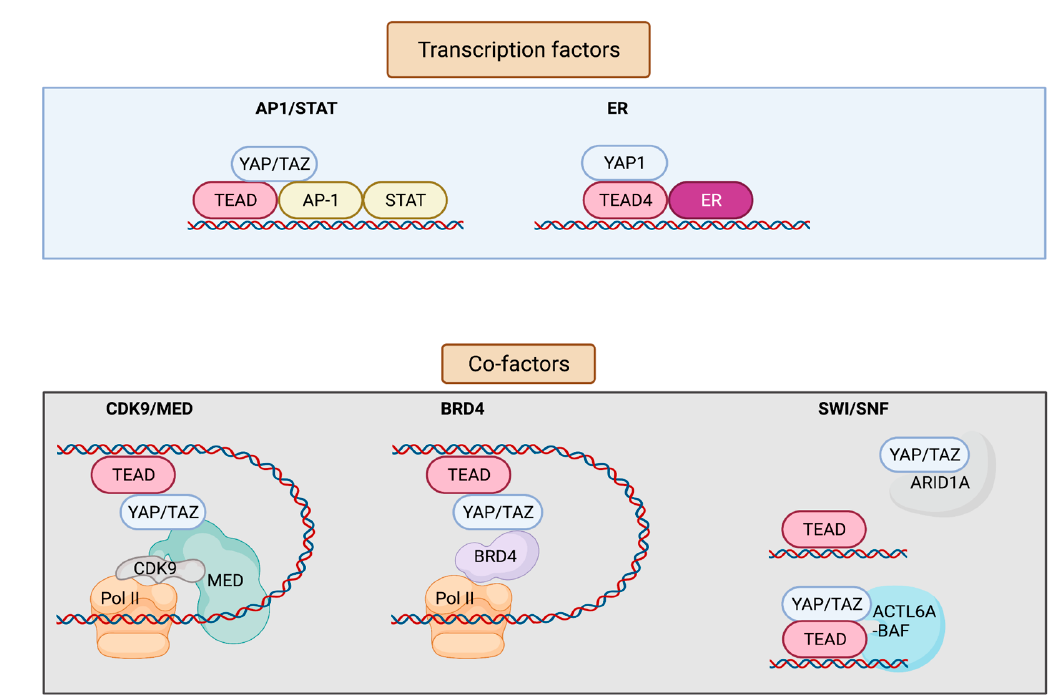
Figure 2. Interaction factors with YAP/TAZ/TEAD. YAP/TAZ/TEAD interact with transcription factors such as AP-1, STATs, and ER to drive transcription. YAP/TAZ/TEAD at enhancers recruit co-factors including Mediator and BRD4 that enable the release of paused Pol II and resumption of transcription elongation. YAP/TAZ/TEAD can also interact with various subunits of the SWI/SNF chromatin remodeling complex. ARID1A is thought to suppress YAP/TAZ transcriptional activity by sequestering YAP/TAZ from TEAD, whereas other subunits including ACTL6A and BRM are thought to promote YAP/TAZ transcriptional activity by enhancing chromatin accessibility at YAP/TAZ/TEAD bound sites. Figure created with BioRender.com.